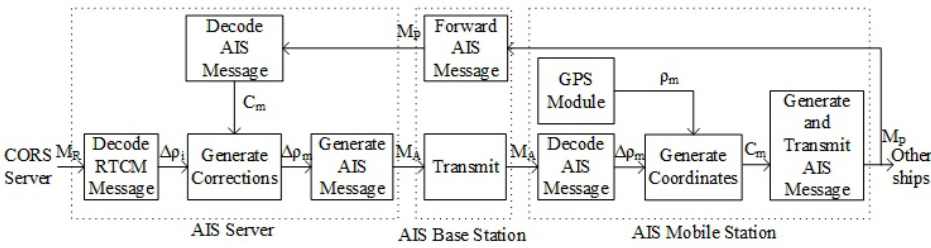
Figure 3. Block Diagram of the differential correction approach using addressed binary